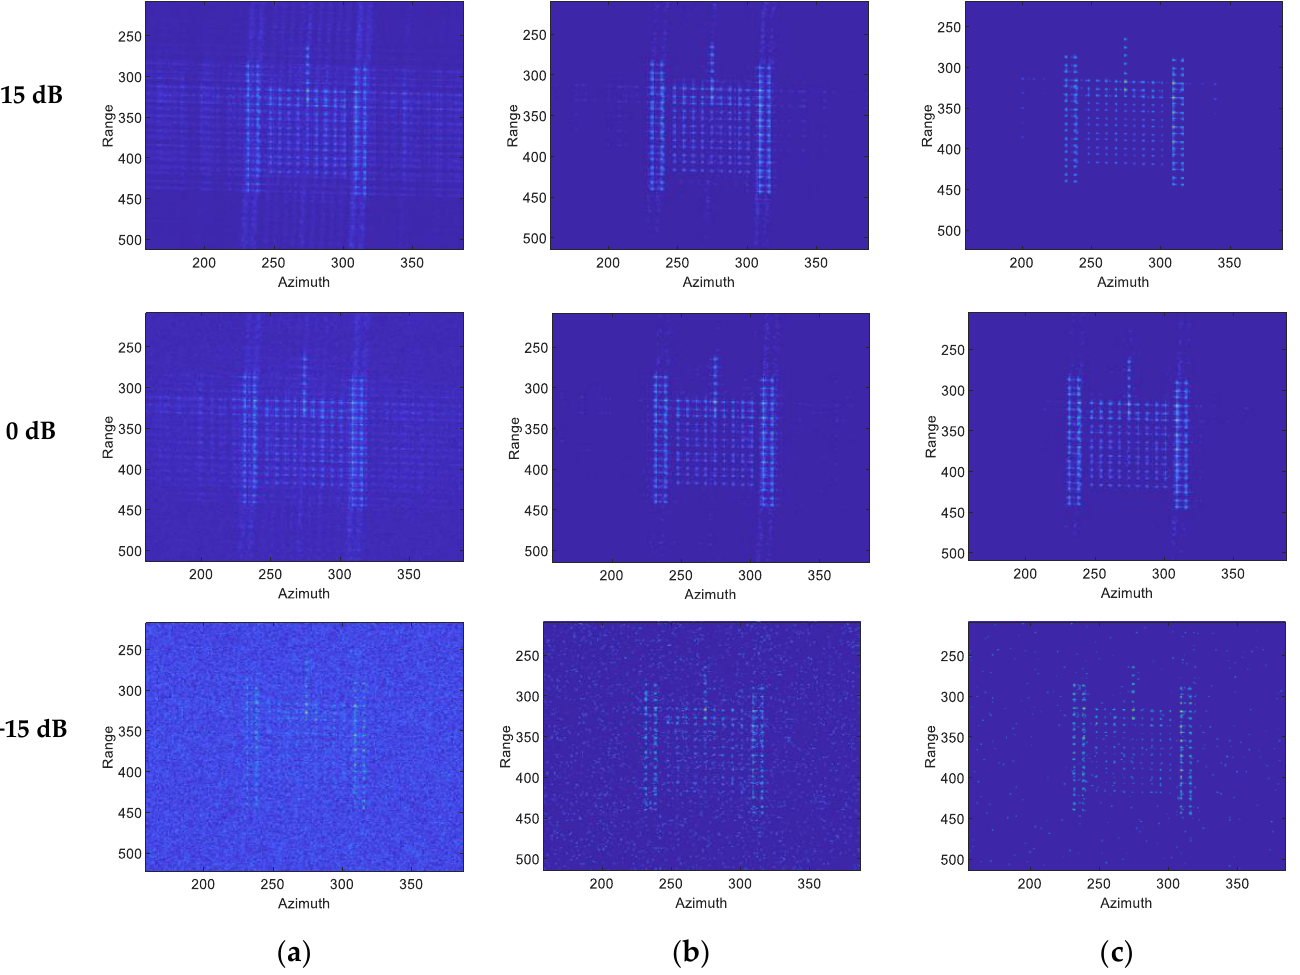
Figure 6. Imaging results of three methods with different SNRs. ( a ) Imaging results of the method in [8]; ( b ) Imaging results of the method in [17]; ( c ) Imaging results of the proposed method. The imaging performance curves for different evaluation metrics versus SNR are